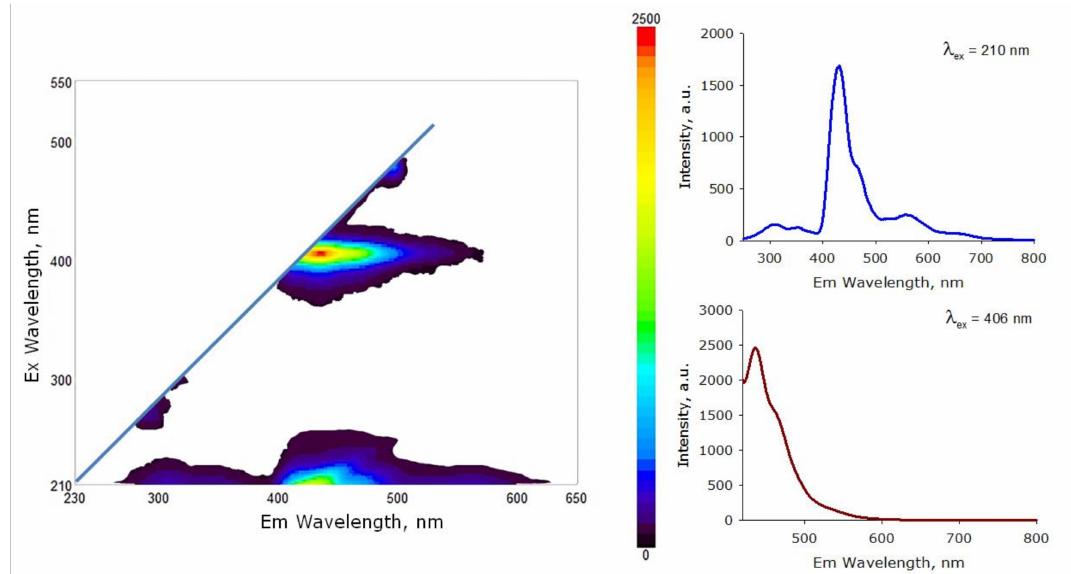
Figure 10. Photoconversion properties of AP-ZnO material. On the left is a 2D graph characterizing the fluorescence intensity of the material at all investigated wavelengths. On the right are the material fluorescence spectra upon excitation at 210 nm ( top ) and 406 nm ( bottom ).